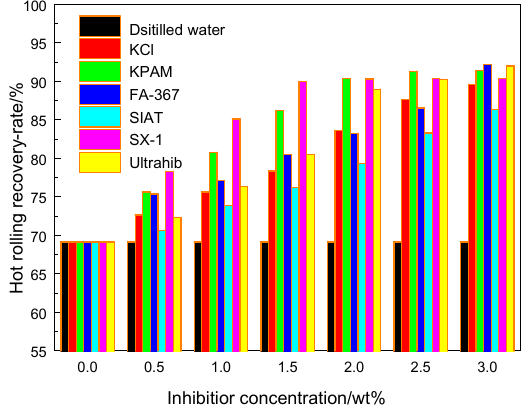
Figure 6. Hot-rolling recovery tests of several shale inhibitors.